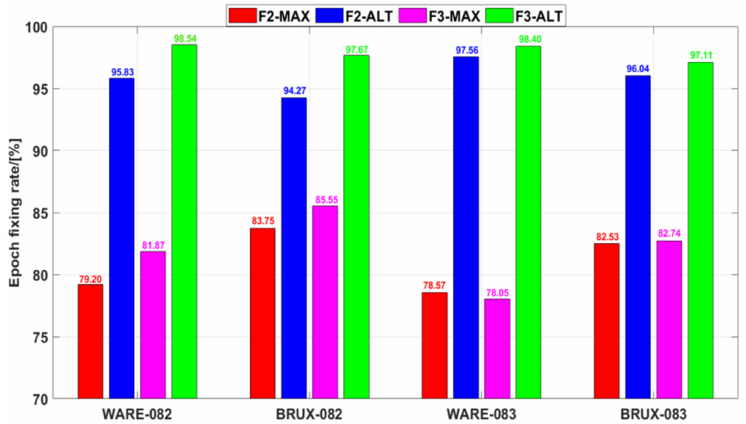
Figure 6. Epoch fixing rate of UCPPP